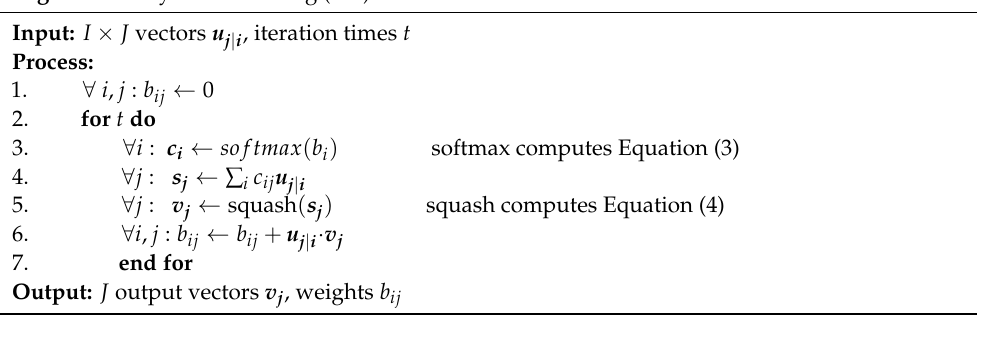
Algorithm 1 Dynamic Routing (DR).